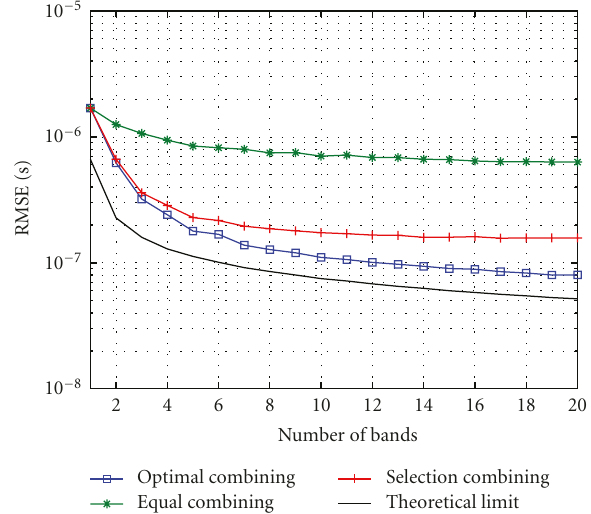
Figure 7: RMSE versus the number of bands for the proposed algorithms, and the theoretical limit (CRLB). Each band occupies = 0 . 1 for all i 100 kHz, and σ 2 i